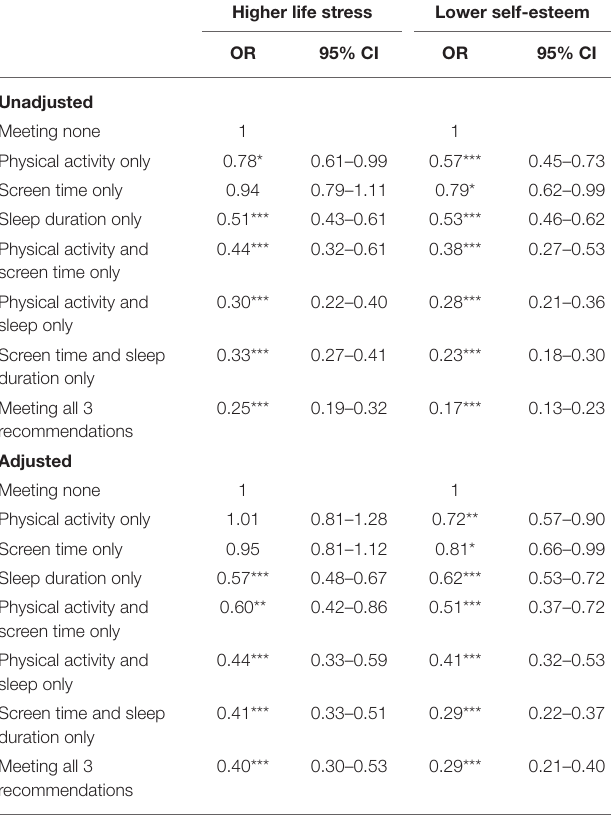
TABLE 2 | Results of the ordered logistic regression analysis of the associations of meeting different combinations of movement behavior recommendations with life stress and self-esteem among adolescents ( N = 6,932).